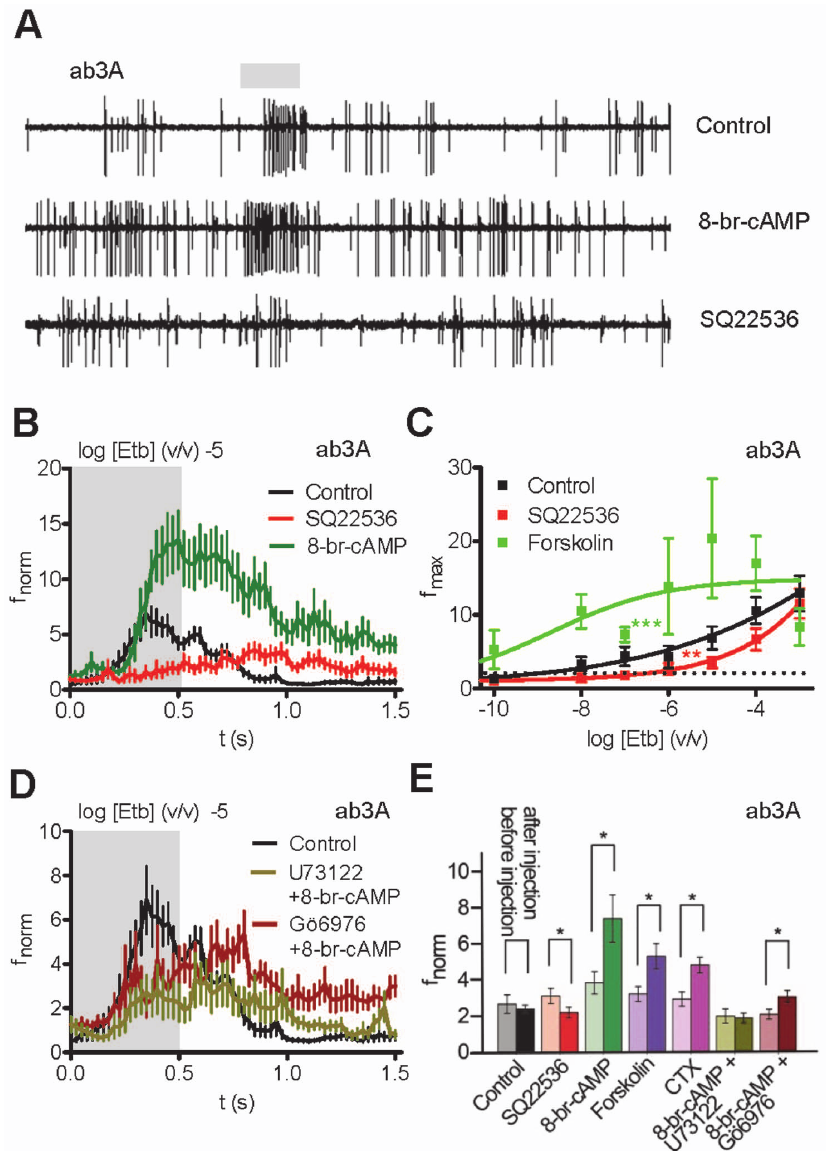
Figure 3. Manipulation of cAMP signalling in Drosophila ab3 sensilla affects the odorant response. A , Recordings of neuronal activity (large action potentials, Or22a neuron; small action potentials, Or85b neuron) before and after Etb stimulation ( 2 5 v/v; 0.5 s, shaded area) in the presence of indicated compounds. While 8-br-cAMP enhances the Etb response, inhibition of adenylyl cyclase with SQ22536 attenuates it. B , Normalized spike frequency (f norm ) of ab3A upon Etb stimulation (0 to 0.5 s, shaded area) at indicated dilution after injection of saline solution (Control; n =11), of 8-bromo-cAMP ( n =11; P , 0.05, Mann-Whitney U test) and of the adenylyl cyclase inhibitor SQ22536 ( n =17; P , 0.01, U test). C , Concentration dependence of the maximum frequency f max of f norm to Etb stimulation after saline, forskolin and SQ22536 injection (** P , 0.01, *** P , 0.001, ANOVA). D , f norm as described in (B) after injection of saline solution (Control; n =11), U73122 plus 8-br-cAMP ( n =10; P =0.18, U test), and Go¨6976 plus 8-br-cAMP ( n =17; P =0.16, U test). In the presence of the PLC or PKC inhibitors 8-br-cAMP fails to enhance the odor response. E , Comparison of treatment effects on Etb response before and after microinjection. f norm on Etb stimulation (0.5 s) as determined from area under the curve measurements of the total response (1.35 s). Responses to Etb were measured 20 s after commencement of recording (before injection) and 200 s after injection (after injection) of the control ( n =11), SQ22536 ( n =17), 8-br-cAMP ( n =11), forskolin ( n =9; data from Olsson et al., 2011), cholera toxin (CTX; n =12), 8-br-cAMP plus U73122 ( n =10), and 8-br-cAMP plus Go¨6976 ( n =17). Error bars represent s.e.m. Asterisks indicate significant differences ( P , 0.05, Paired Wilcoxon Signed-Rank Test).